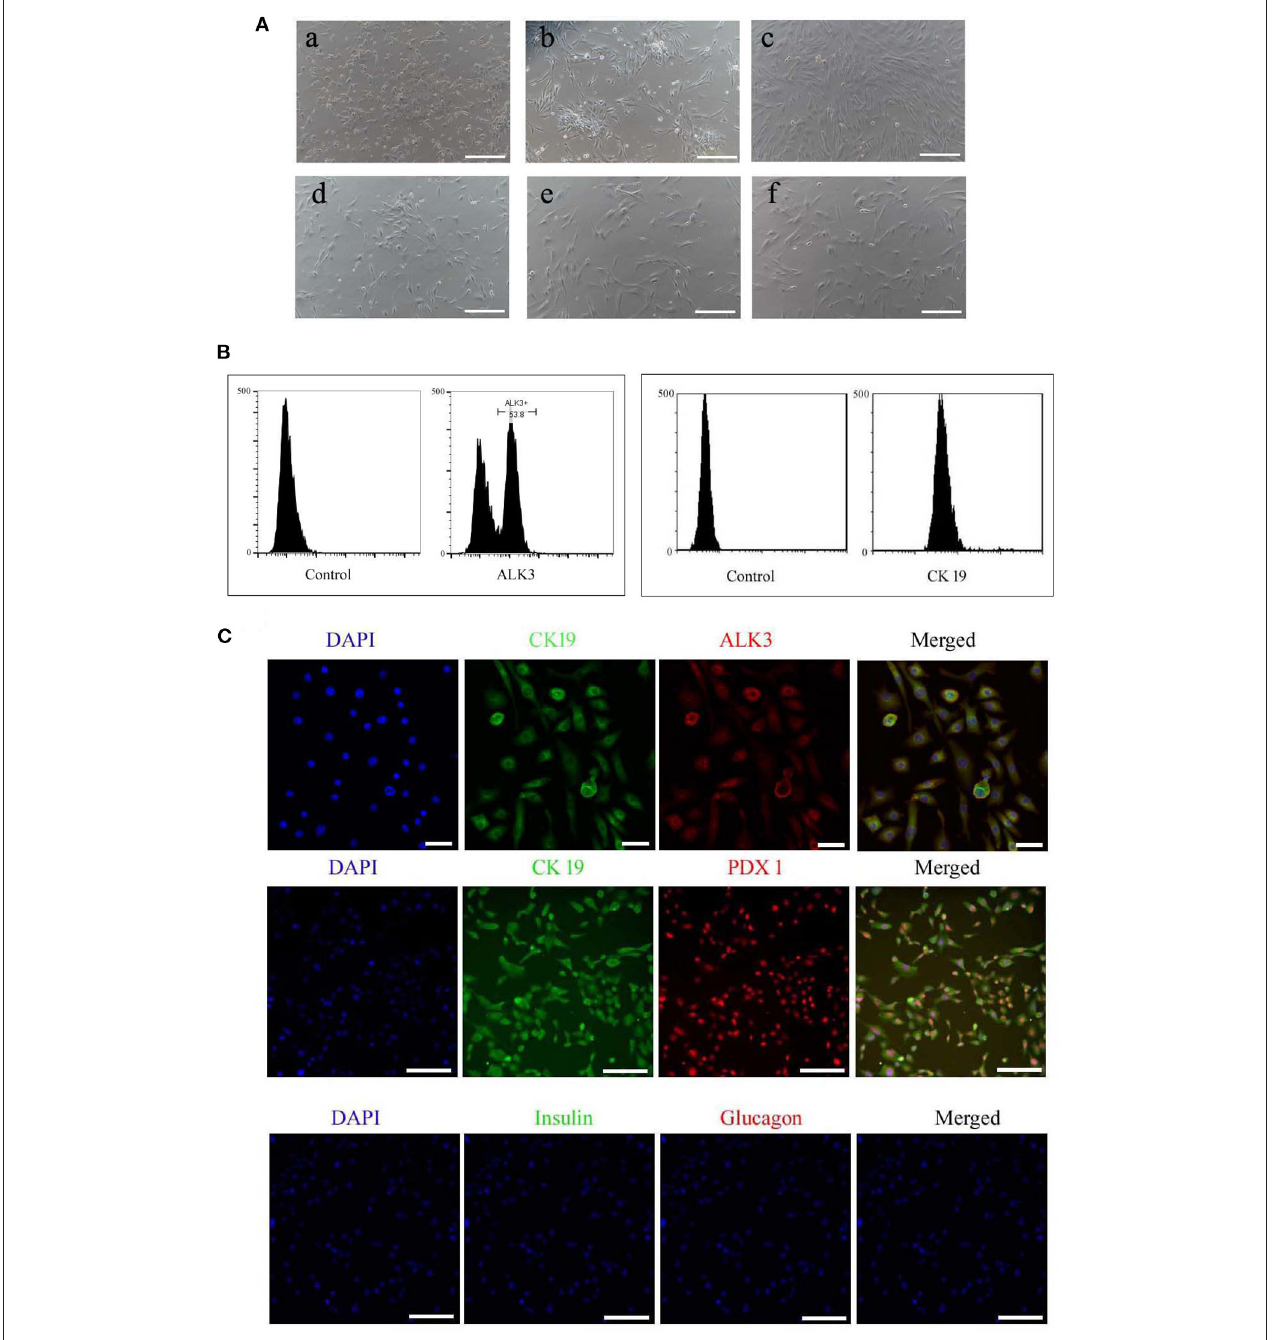
FIGURE 2 | Morphology and specific makers in pancreatic ductal cells. (A) Morphology of primary cultured and sub-cultured pancreatic ductal cells in vitro . (a) Pancreatic cells plated onto microplates after 72h. (b) Pancreatic ductal cells were purified by ALK3 antibody using FCM and plated onto culture plates after 72h. (c) Pancreatic ductal cells before subculture. (d) Pancreatic ductal cells at passage 3. (e) Pancreatic ductal cells at passage 9. (f) Pancreatic ductal cells at passage 15. Scale bar = 100 µ m. (B) ALK3 positive cells were purified using FCM from primary cells (left penal), the data showed more than 50 percent cells were positive for ALK3 in pancreatic primary cells. CK 19 is a universal marker for pancreatic ductal cells, and then expression of CK 19 were analyzed in the purified cells using FCM (right penal). The data indicated the purified cells were positive for CK 19. (C) Detection of CK19, ALK3, and PDX1 by IF staining in purified pancreatic ductal cells. The data demonstrated that PDX1 was located in the nucleus, CK19 was positive in the cytoplasm, ALK 3 was positive in cytomembrane, and insulin and glucagon were negative in pancreatic ductal cells. Scale bar = 50 µ